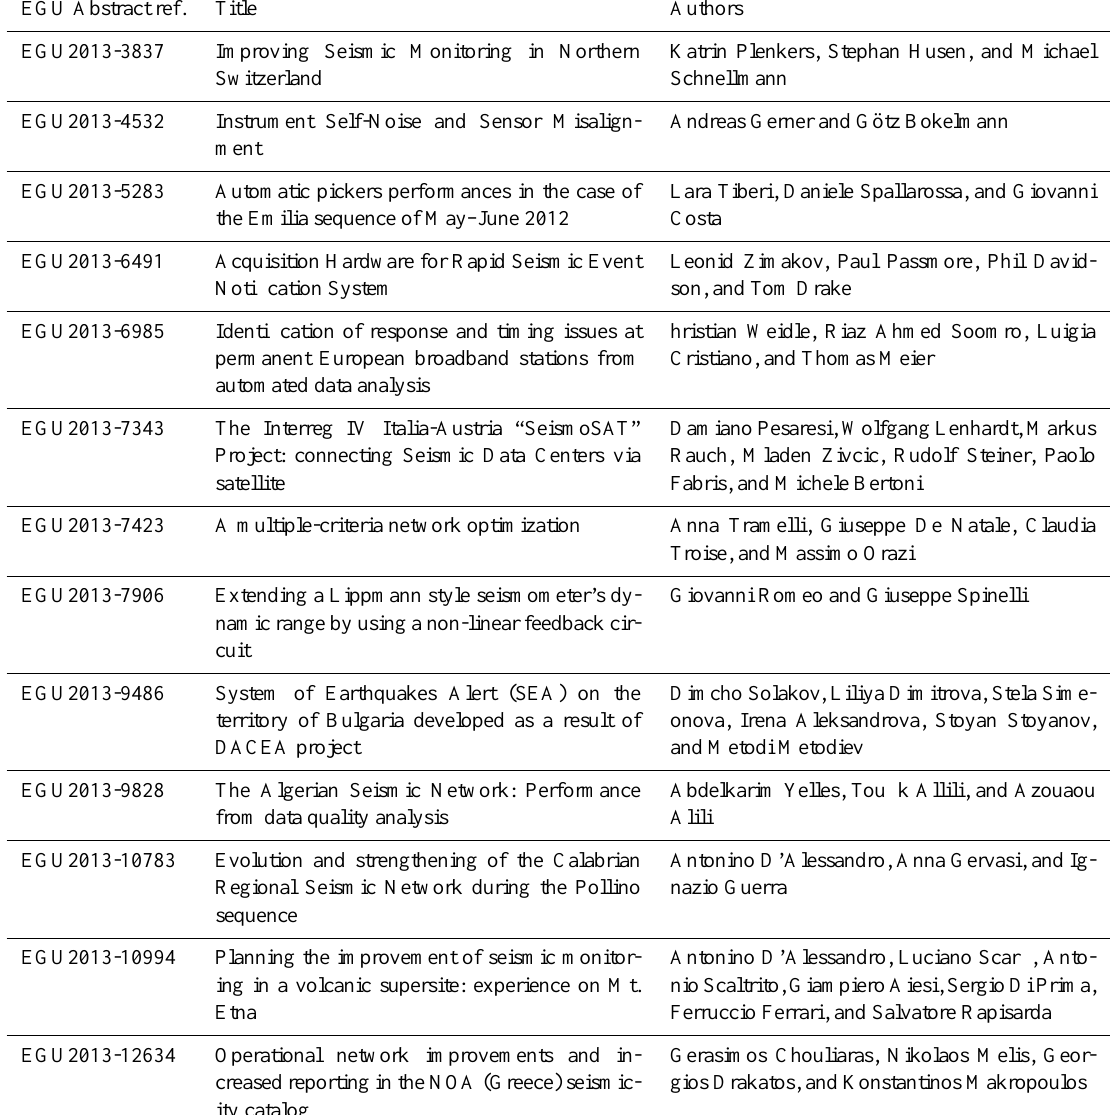
Table 2. Poster Programme EGU2013 SM1.4/GI1.6